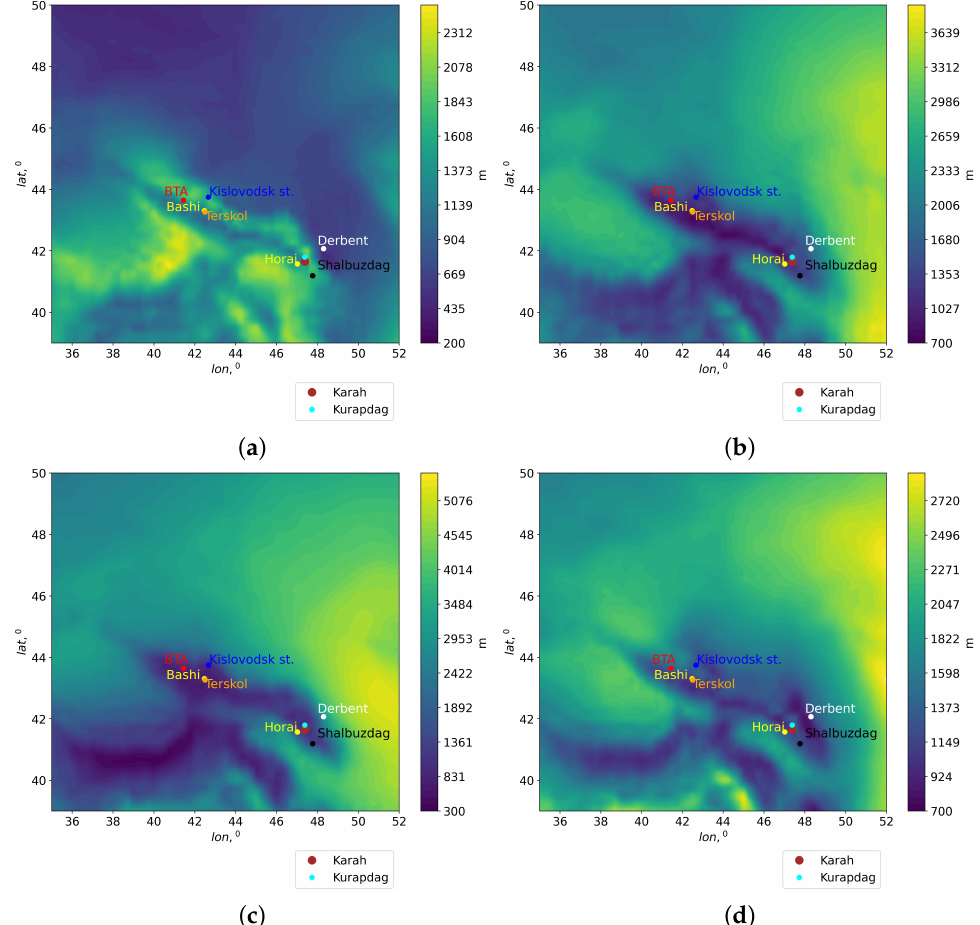
Figure 8. Spatial distributions of cloud base height for different seasons for the period 2010–2020: ( a ) winter; ( b ) spring; ( c ) summer; ( d )